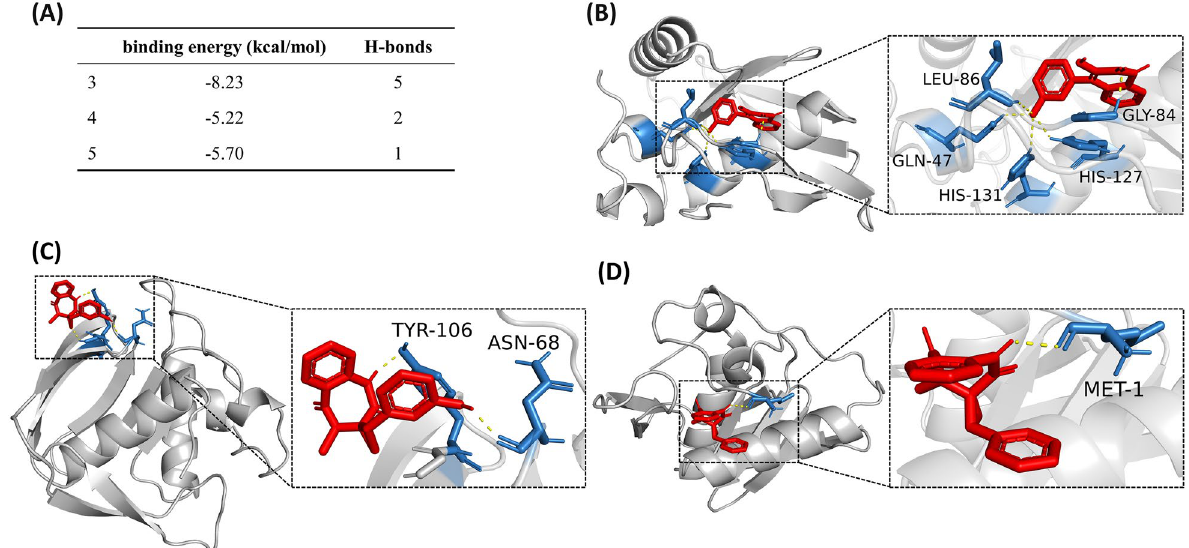
Fig. 3 Molecular docking of compounds 3 , 4 and 5 on the PDF of V . parahaemolyticus . A The binding energy and number of H-bonds of the three compounds on the PDF of V . parahaemolyticus . B – D Images showing the binding pockets of the docking between compounds 3 ( B ), 4 ( C ) and 5 ( D ) and the PDF of V .